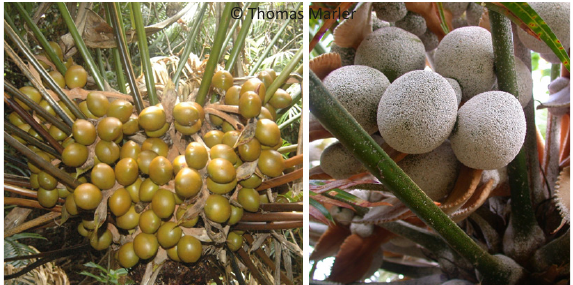
Image 3. Cycas micronesica female strobili bear naked seeds as with all gymnosperms (left), and direct attack by Aulacaspis yasumatsui (right) reduces germination percentage and seedling vigor.